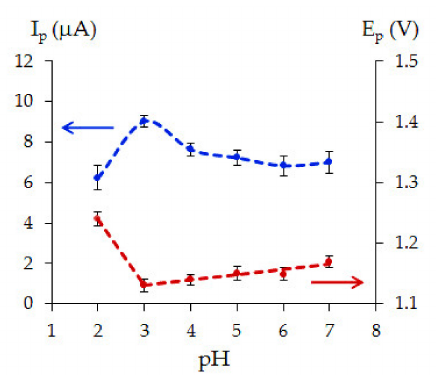
Figure 8. E ff ect of background electrolyte pH on the nitrite oxidation peak current (I p ) and peak potential (E p ) on the TrX100 / FCVE. Solution: BRB + 0.02 mM NO 2 −